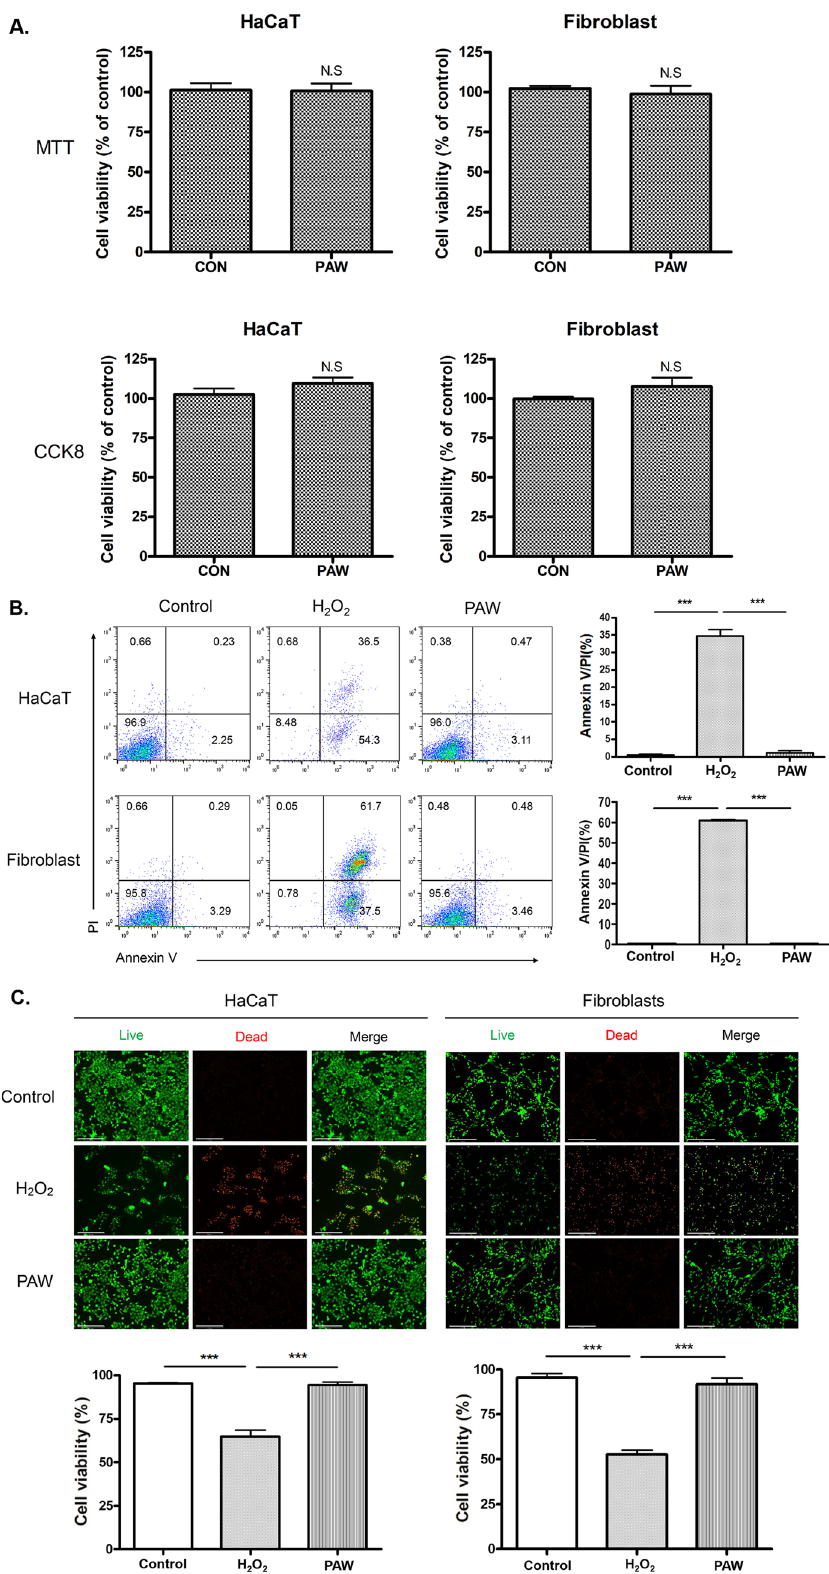
Figure 5. Skin protective effects of plasma-activated water (PAW) in vitro. ( A ) In normal skin cells (i.e., HaCaT and fibroblasts), cell viability was investigated by MTT and CCK8 assays after treatment with PAW and de-ionized water as a control (CON). There was no significant difference in cell viability between in the PAW-treated group and the control. ( B ) Annexin V/PI assay and quantification of HaCaT cells (upper) and Fibroblasts (lower) after treatment with DW as a control, PAW, and H 2 O 2 . ( C ) Live/dead cell assay evaluated by microscopy with a magnification of 200 × (scale bar, 200 μm). Live cells are marked with green-fluorescent calcein. No dead cells were visible in control and PAW-treated groups. H 2 O 2 -treated groups showed significant dead cells with red fluorescence in both HaCaT cells and fibroblasts. Three replicate measurements were used for statistical analyses. ***P <